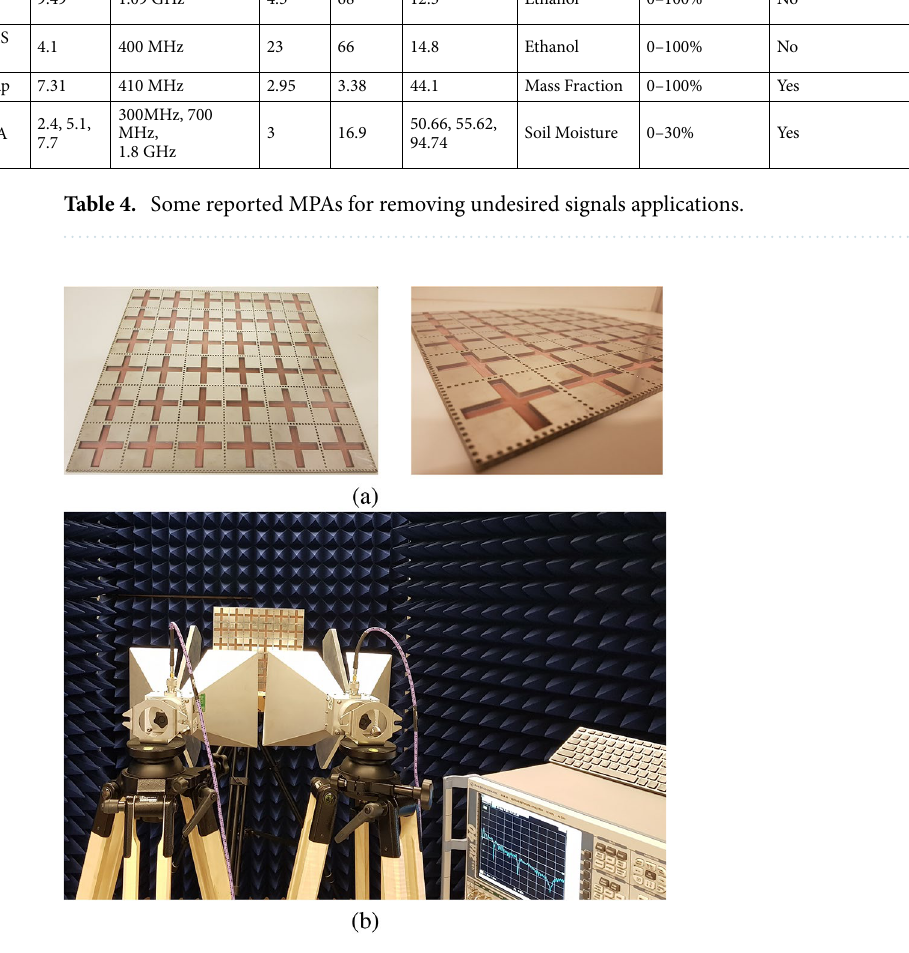
6 MPA, ( b ) Implemented measurement ×